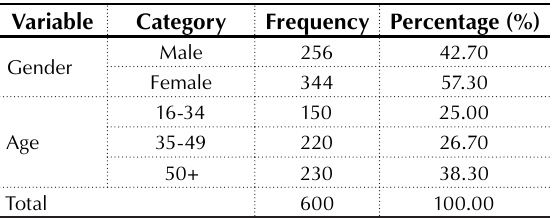
Table 2. Demographic information of the